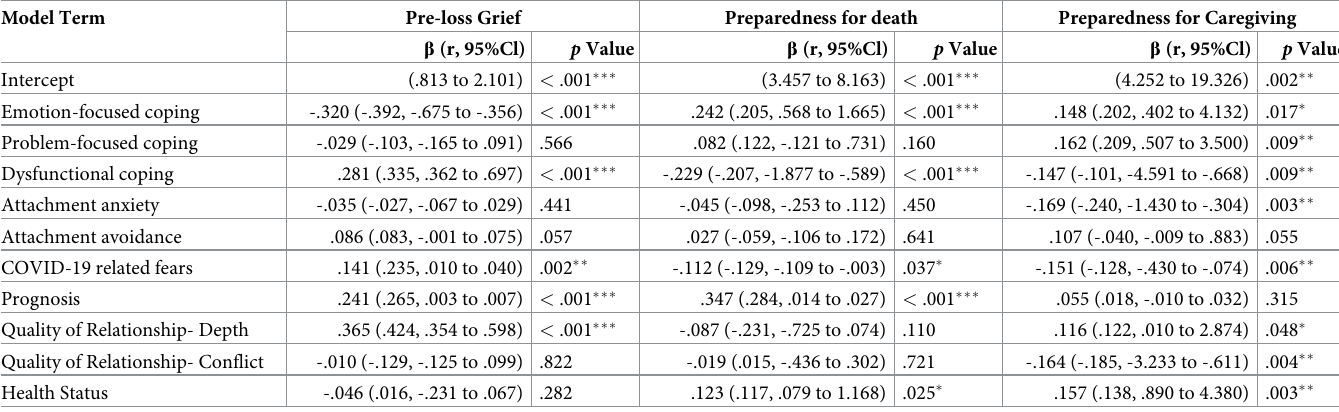
Table 3. Multivariate regression